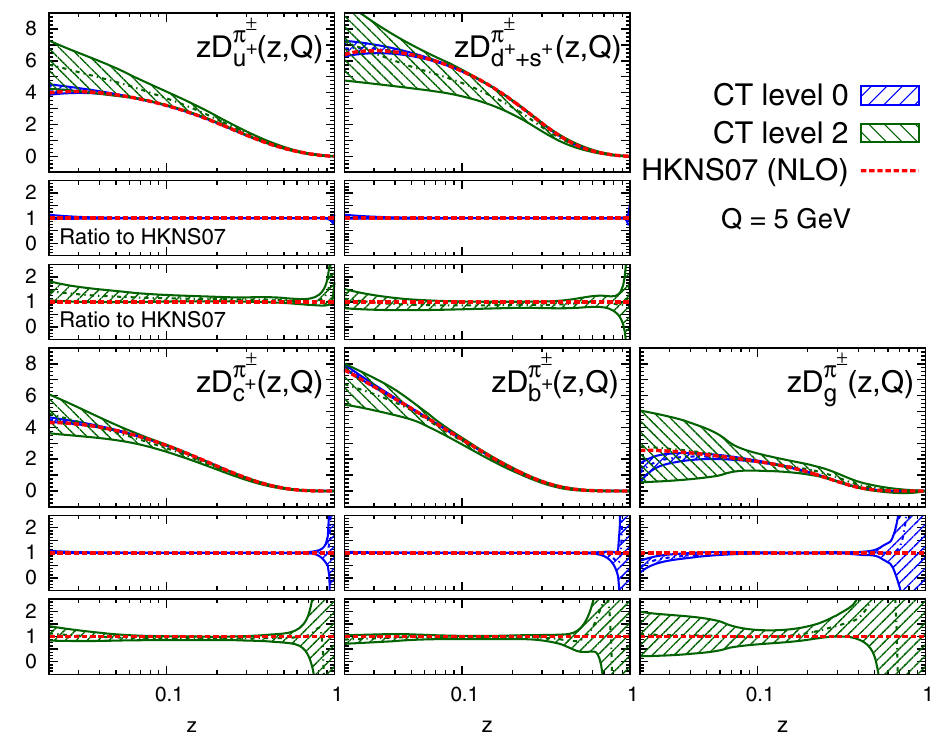
Fig. 3 Comparison between the central value of the charged pion GeV, in the z range which roughly matches the kinematic coverage of the fitted data. Shaded bands indicate their one- σ uncertainties. The HKNS07FFs[62]( reddashedline )andthecorrespondingFFsobtained central ( lower ) inset show the ratio of the L0 (L2) FFs to the HKNS07 from the L0 ( blue bands ) and L2 ( green bands ) closure tests. The five ± ± ± FFs panels show the D π ± g , D π ± , D π , D π , and D π FFs at Q = 5 u + d + + s + c + b +